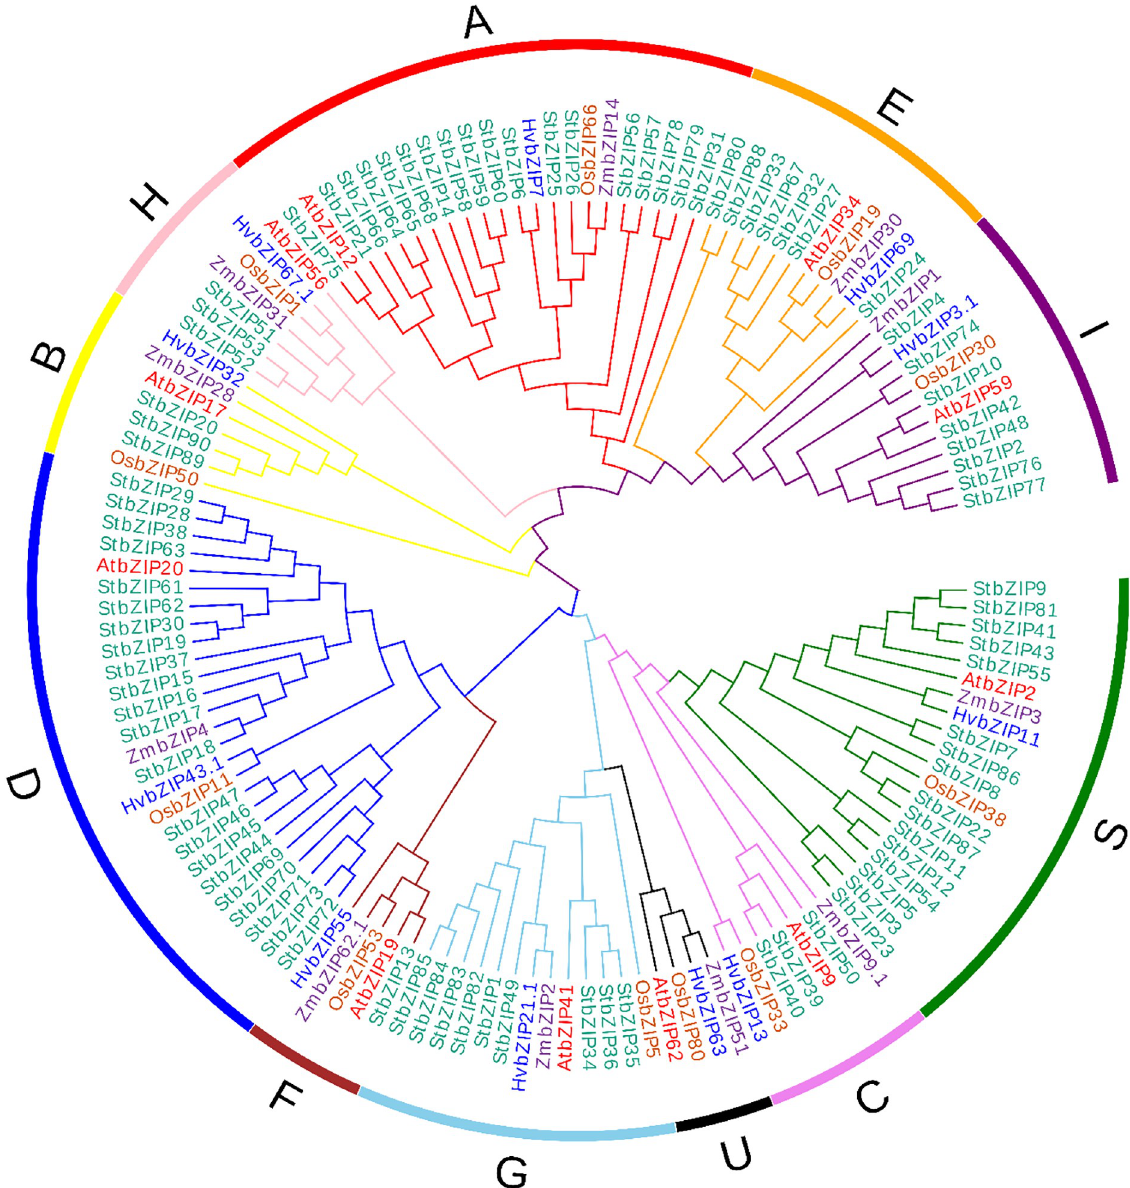
Fig 3. Phylogenetic tree of StbZIPs. The phylogenetic tree with representative bZIPs of each group from Arabidopsis , rice, maize, barley, and potato (denoted using red, blue, purple, brown, and green stars, respectively) was constructed using the Neighbor-joining (NJ) method by MEGA 7 with 1000 bootstrap values. The StbZIPs were categorized into 11 groups and are shown by colored branches A to I, S, and U.